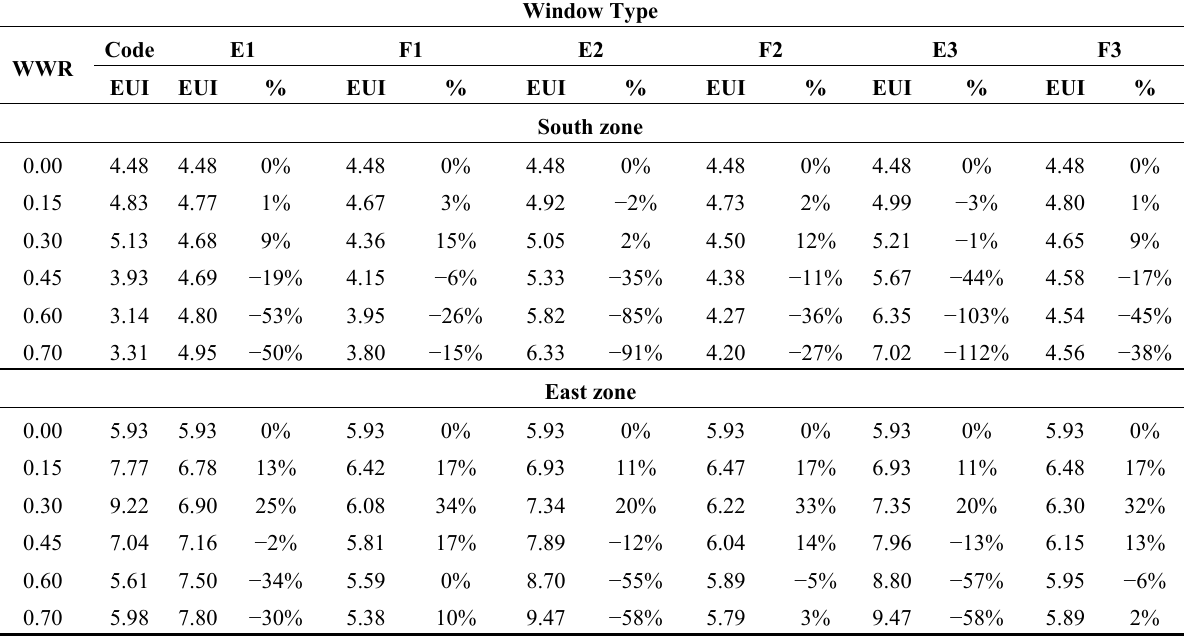
Figure 3. Disaggregated energy use (MJ/m 2 -year) for perimeter zones in Beijing. Table 6. Zone heating load (MJ/m 2 -year) and percent savings compared to the GB 50189-2005 Standard for